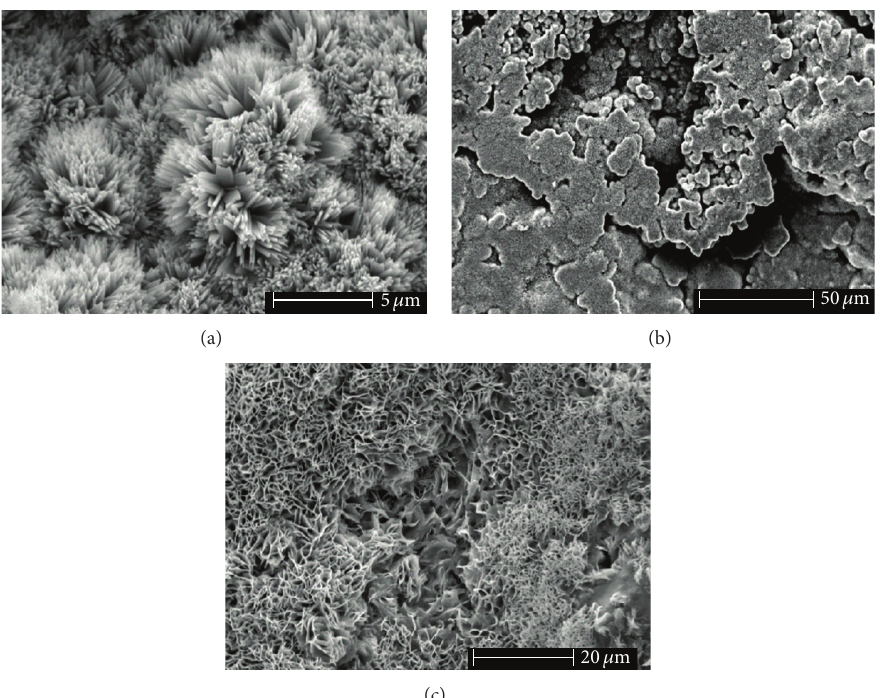
Figure 10: Micrographs showing (a) sharp structures (crystalline goethite); (b) flatten and dark disks of magnetite; and (c) flowery structures typical of